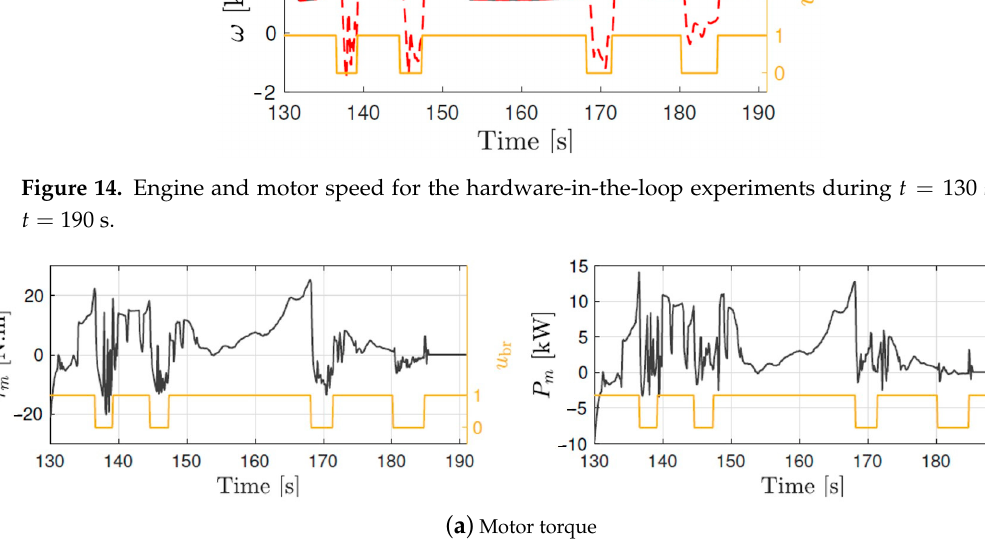
Figure 15. Motor operation for the hardware-in-the-loop experiments during t = 130 s to t = 190 s ( a ) motor torque, ( b ) motor